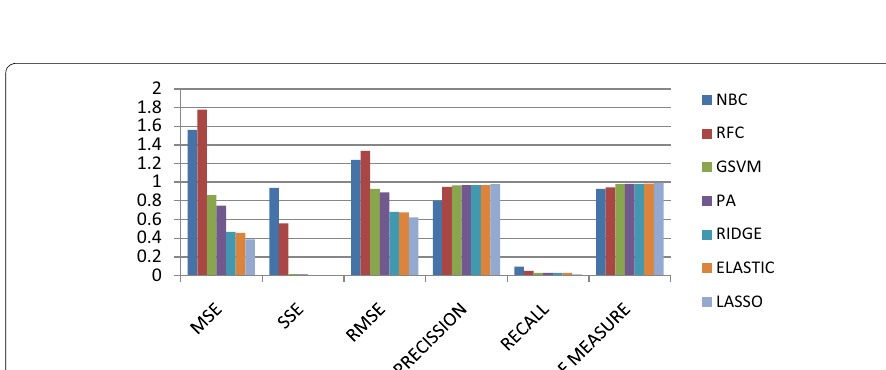
Fig. 4 Performance metrics for different classifiers under FERET database